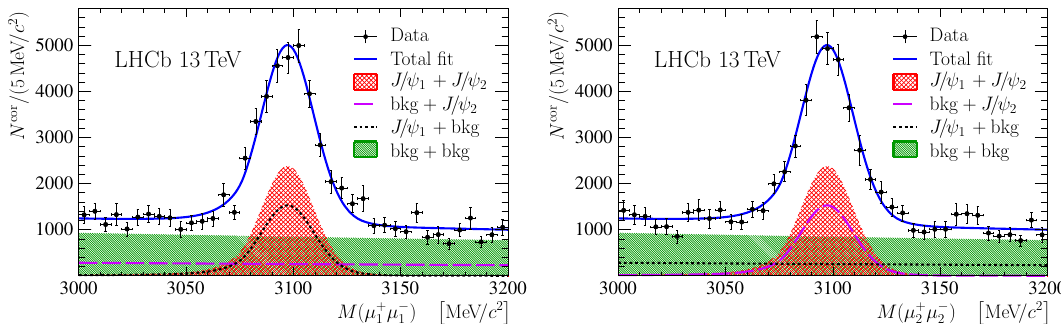
Figure 1. Projections of the (cid:12)t to the e(cid:14)ciency-corrected distribution of the reconstructed J= mass for (left) M ( (cid:22) + (cid:22) (cid:0) ) and (right) M ( (cid:22) + (cid:22) (cid:0) ). The (black) points with error bars represent the 1 1 2 2 data. The (blue) solid line is the total (cid:12)t function. The (red) cross-hatched area shows the signal distribution. The (black and magenta) dashed lines represent the background components due to the combination of a real J= with a combinatorial candidate. The (green) shaded area shows the purely combinatorial